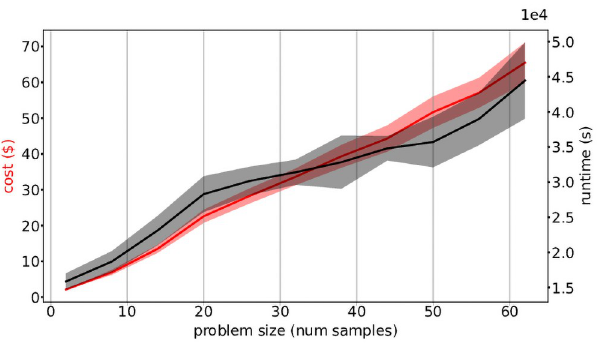
Fig 4. Mean runtime and cost across problem sizes. Average runtime and cost of the workflow for different problem sizes, with shaded regions indicating standard deviation. Both metrics increased linearly with problem size, and show higher variability for increasing problem sizes. Execution took a minimum of around 3 hours for the smallest problem size of 2 samples, up to nearly 13 hours for 62 individuals, with costs ranging from $2 to $70. Task types are represented by the same colors as in Fig